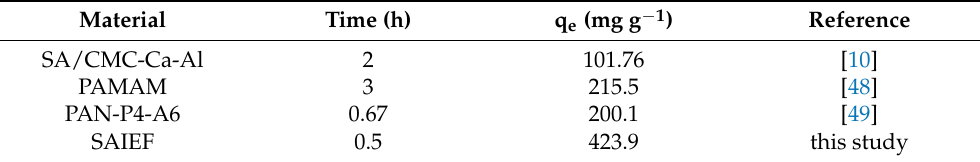
Table 3. Comparison of adsorption capacity of various adsorbents for uranium from